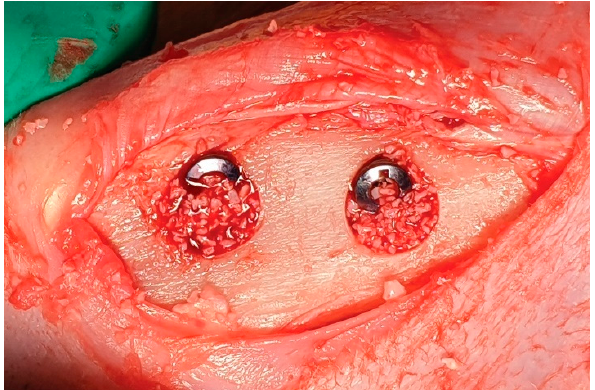
Figure 3. Clinical photograph illustrating implants placed in the rabbit tibia, with xenogenic graft materials placed in the gap defects.